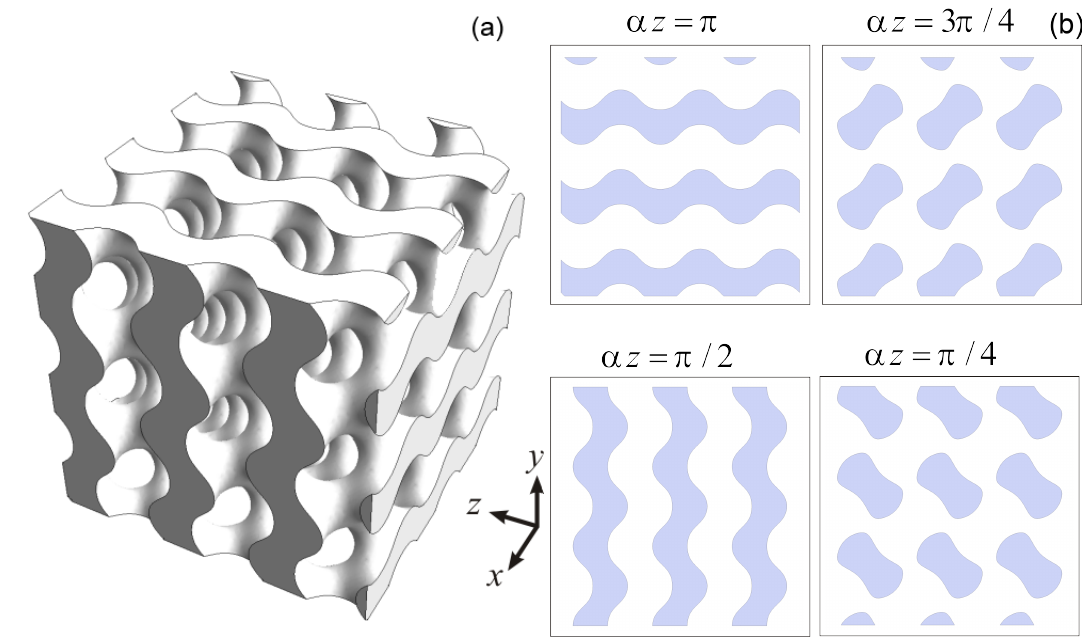
Figure 2. ( a ) The gyroid-based structure with porosity 60%; ( b ) The cross-sections of gyroid structure with porosity 60% in the plane perpendicular to z-axis (gray regions are related to material, white—to the